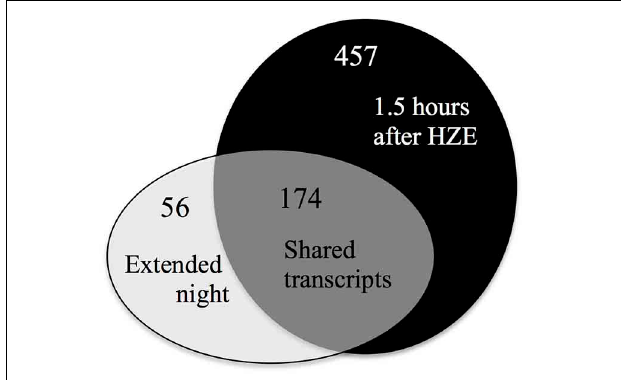
FIGURE 7 | Most transcripts induced by extended night are also induced by HZE. Overlaps between up-regulated transcripts (fold change > 2 and adjusted p -value < 0.05) induced early in the response to HZE treatment (at 1.5h in both WT and atm-1 ) vs. induced persistently in response to extended